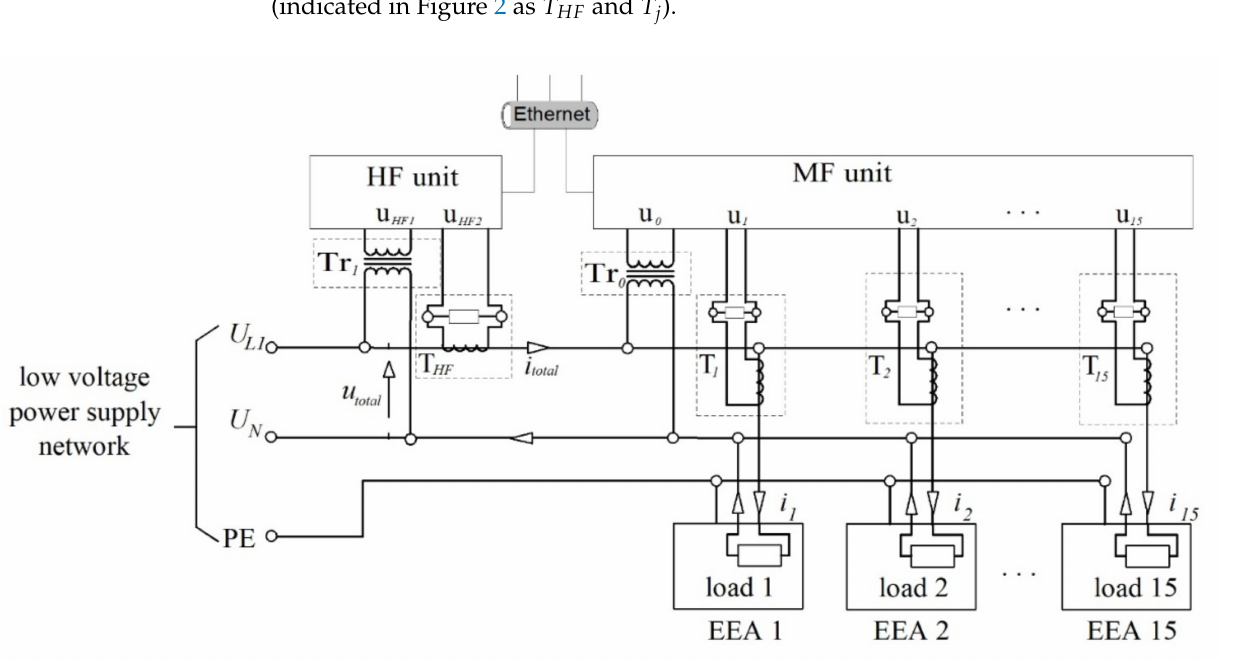
Figure 2. Scheme of measuring